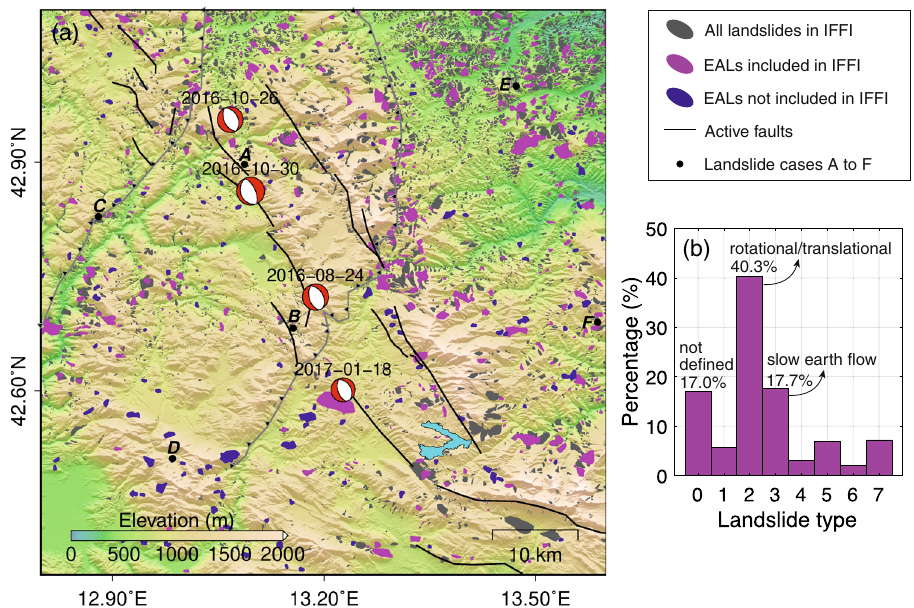
Fig. 2 | Established Earthquake Accelerated Landslide (EAL) inventory. a Distribution of detected EALs and landslides documented by the inventory of landslidephenomenainItaly(IFFI).GraypolygonsareIFFI-documented landslides. Magentaandnavy-bluepolygonsarerespectivelyEALsalreadyinIFFIandEALsnot in IFFI. Black dots indicate the spatial locations of six landslide cases used for